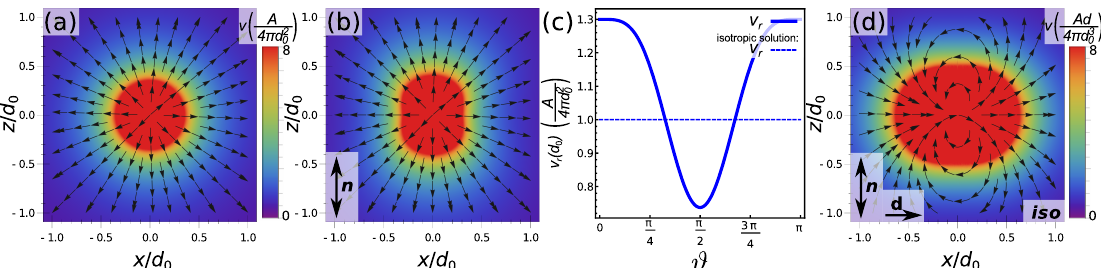
Figure 5. Flow field of point source in ( a ) isotropic and ( b ) nematic fluid; and ( c ) radial flow velocity for a source flow (Equation (40)) shown for an isotropic and for a nematic fluid as a function of the azimuthal angle. In nematic fluid, the velocity field retains the radial direction; however, its amplitude as a function of azimuthal angle θ shows an increase along the z -axis—the director—and a decrease perpendicular to the director. Note that the flow field of a point sink is obtained directly by taking the opposite sign of the flow field of the source; ( d ) flow source and sink can be combined in a source dipole, here shown for isotropic